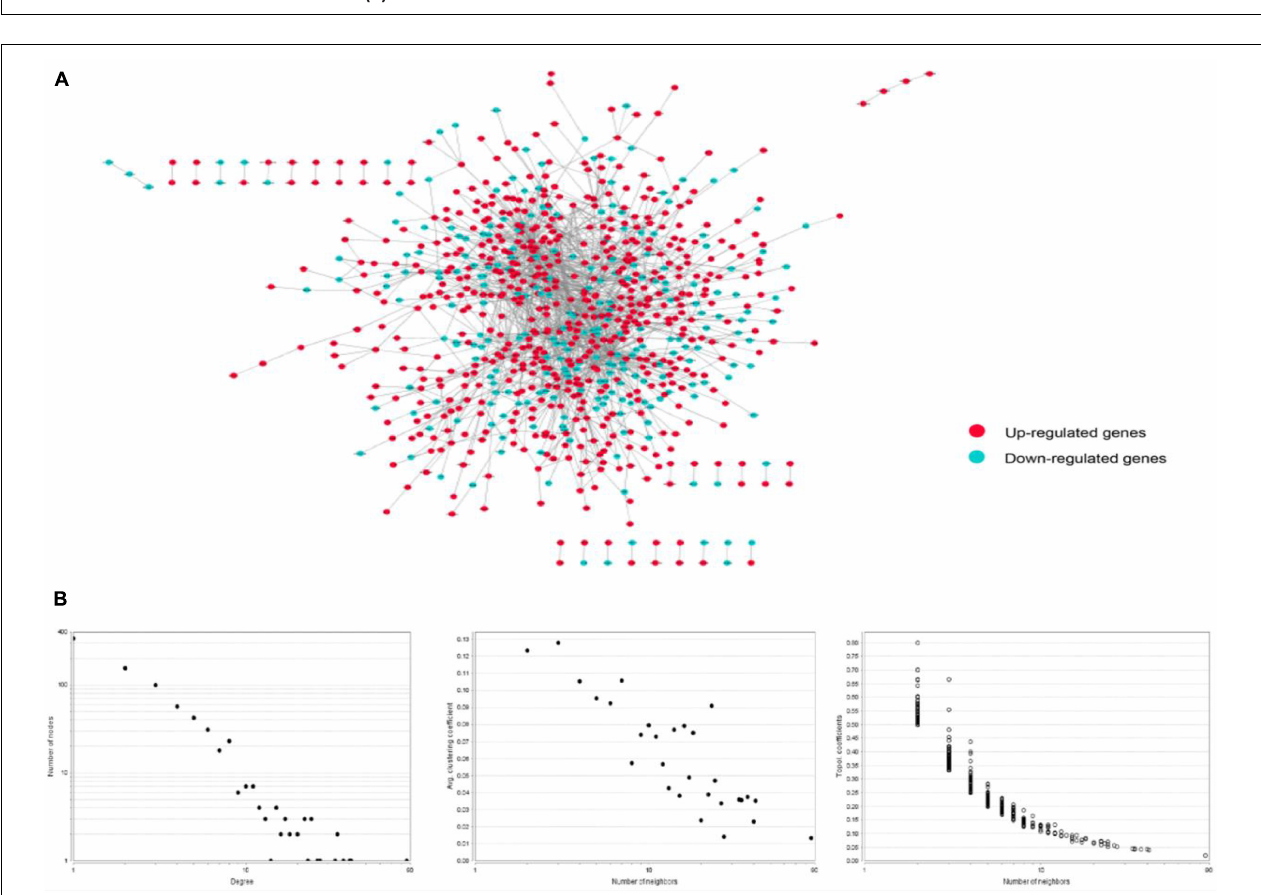
Differential gene expression was performed using the R package “limma” with a P -value < 0.05 and logFC change > 0.58 set as thresholds to determine differentially expressed genes (DEGs) and volcano plots were plotted to display the results.